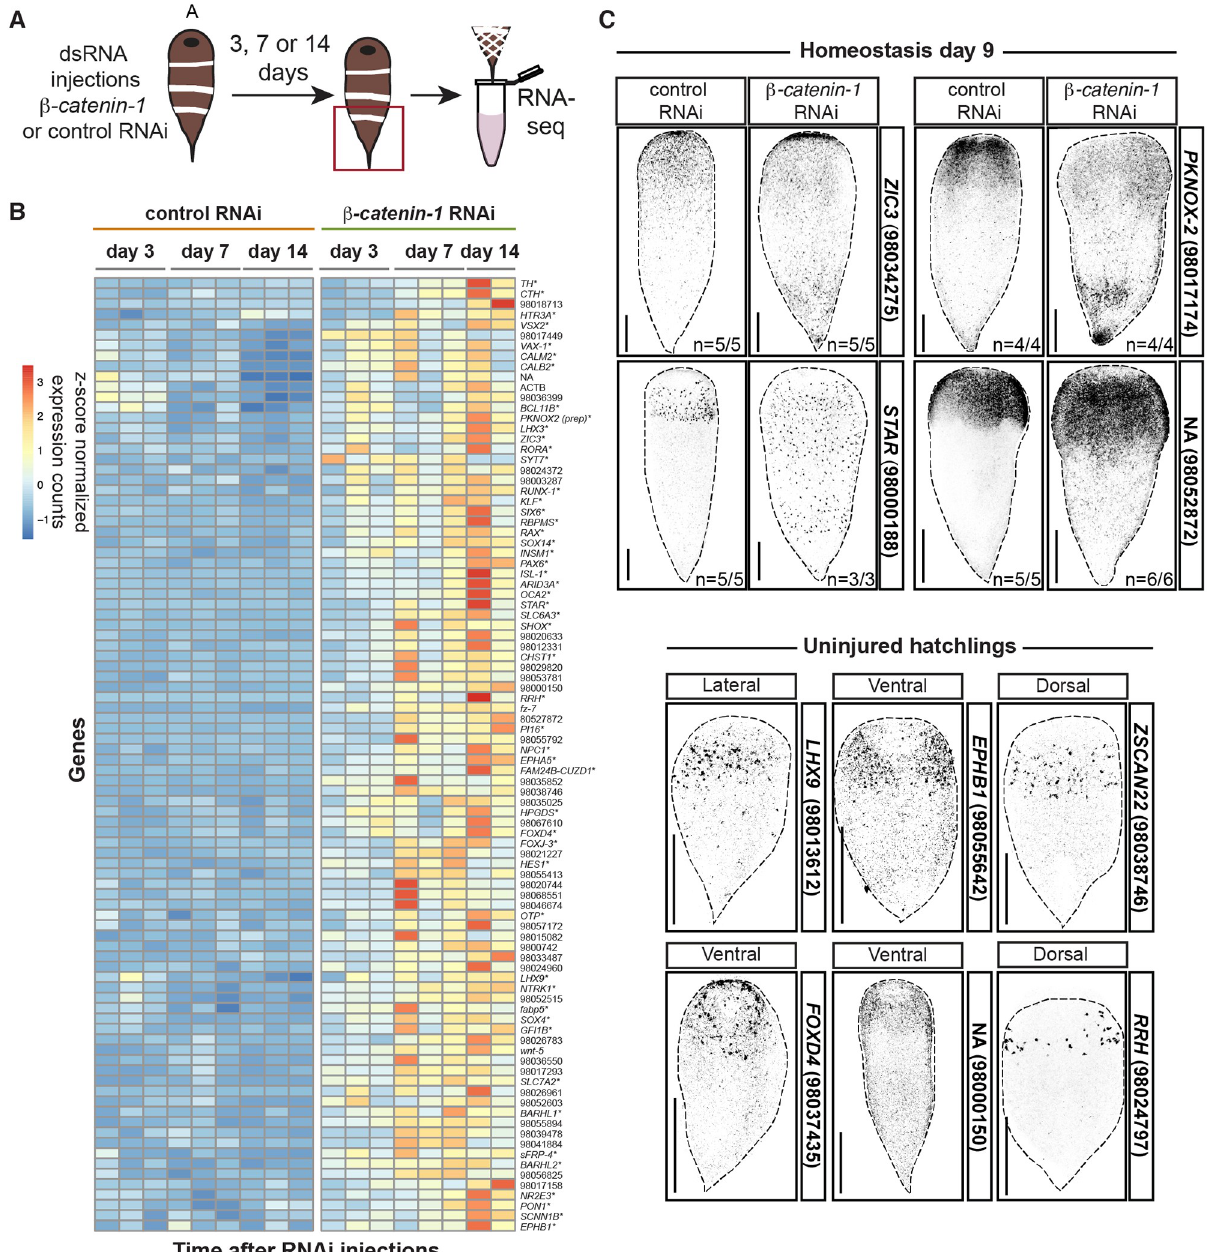
Fig 4. An anterior program of gene expression is up-regulated after β -catenin-1 inhibition in acoels. (A) Experimental scheme for RNA sequencing. Hofstenia miamia were injected once a day for three consecutive days with control or β -catenin-1 dsRNA. Tails were collected in trizol at 3, 7, and 14 days after the first injection for RNA sequencing. Red box indicates tissue collected. (B) 92 genes are up-regulated early after β -catenin-1 RNAi. Heatmap displaying gene expression counts as a z-score for indicated time-points post-RNAi initiation. � indicates annotation by best BLAST hit. Gene list provided in S5 Table. (C) Top: Validation of β -catenin-1 RNAi dependent up-regulation of gene expression. FISH for indicated transcripts at day 9 post-RNAi initiation in homeostasis. Images are presented in grayscale with color inverted. Bottom: Genes up-regulated after β -catenin-1 RNAi are expressed in the anterior. FISH for indicated transcripts in two week old hatchlings. Transcript ID provided in parentheses. Images are presented in grayscale with color inverted. All scale bars, 200 μ